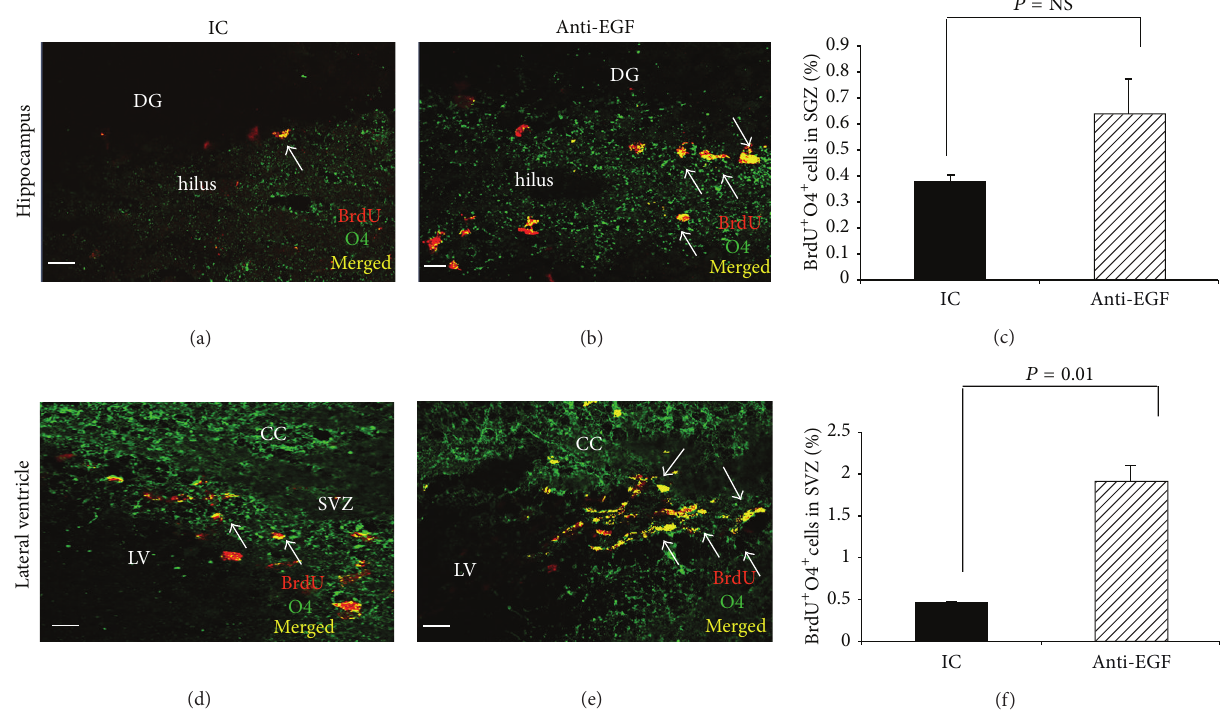
Figure 4: Increased numbers of de novo oligodendrocytes in the SVZ in response to therapy with anti-EGF Ab. Immunohistochemical labeling of BrdU + O4 + cells in the SGZ and SVZ of IC-treated mice (a and d, resp.) and of anti-EGF Ab-treated mice (b and e, resp.) on day 18 after immunization. Quantification of %BrdU + O4 + cells in the SGZ and in the SVZ (c and f, correspondingly) revealed a nonsignificant trend for induction of BrdU + O4 + in the SGZ, along with a significant induction in BrdU + O4 + cells in the SVZ. Images were obtained using a confocal microscopy, coronal sections. Quantification was performed using ZEN 2011 software on 3 sections from each mouse (3 mice from each group, total 𝑛 = 9 ). DG , dentate gyrus, LV , lateral ventricle, SVZ , subventricular zone, and cc , corpus callosum. Scale bar: 10 𝜇 m (magnification = ×